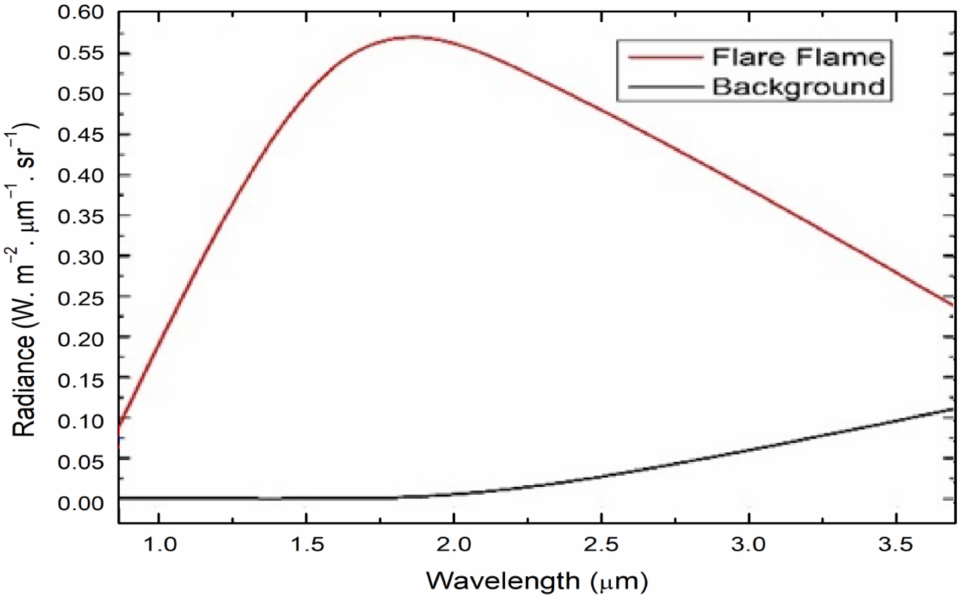
Figure 2. An illustration of the flare flame and background